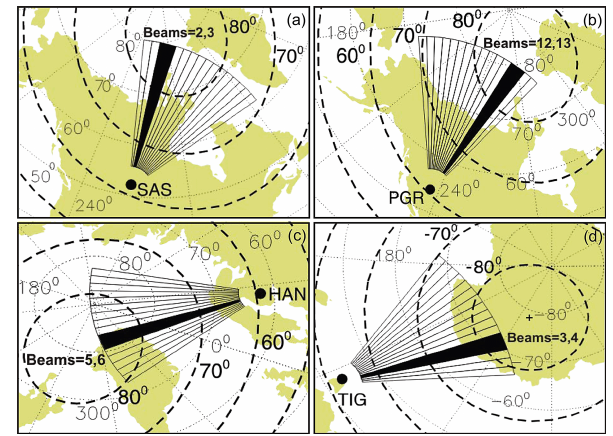
Fig. 1. Field of views of the (a) Saskatoon (SAS), (b) Prince George (PGR), and (c) Hankasalmi (HAN) SuperDARN radars in the north- ern hemisphere and (d) Bruny Island TIGER (TIG) SuperDARN radar in the southern hemisphere. The beams considered (labeled by numbers) are shaded by